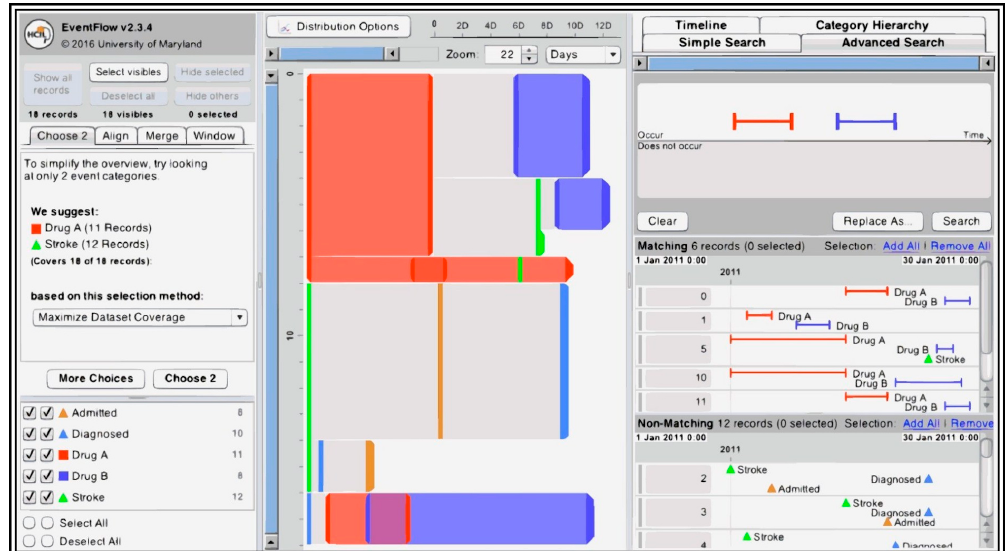
Figure 6. Eventflow: Interactive visualization tool for analysis of event sequences for both point-based and interval events. Source: image courtesy of the University of Maryland Human–Computer Interaction Lab, http://hcil.umd.edu.